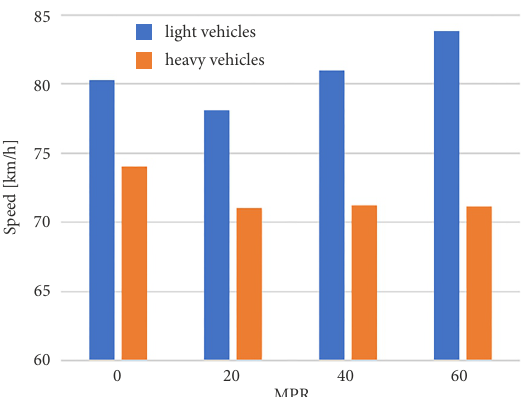
(orange) for different MPRs [km/h] – driving as usual strategy